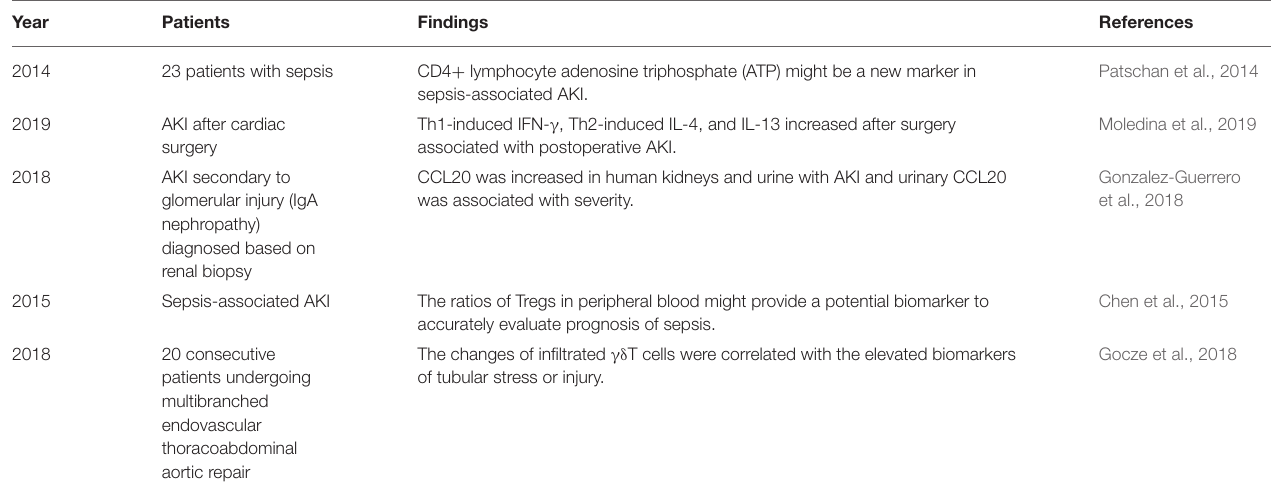
TABLE 2 | The systematically findings of lymphocytes in human studies of